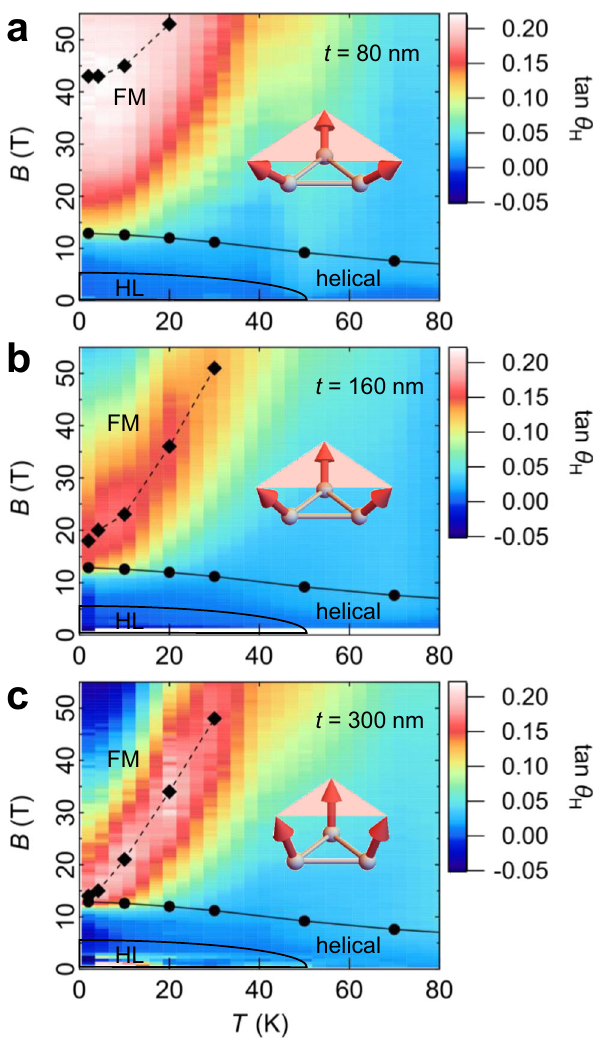
Fig. 3 Film-thickness dependence of the temperature – magnetic- fi eld pro fi le of the AHE in MnGe thin fi lm. Contour plot of tan Θ H ð¼ σ xy = σ xx Þ for the thickness of t ¼ 80 ( a ), 160 ( b ), and 300 nm ( c ). The solid diamond markers connected by a dashed line represent the maximum point of tan θ H at each temperature. The insets are the intuitive schematics to explain the fact that the larger scalar spin chirality excitation is more favorable in thinner fi lms with enhanced in-plane magnetic